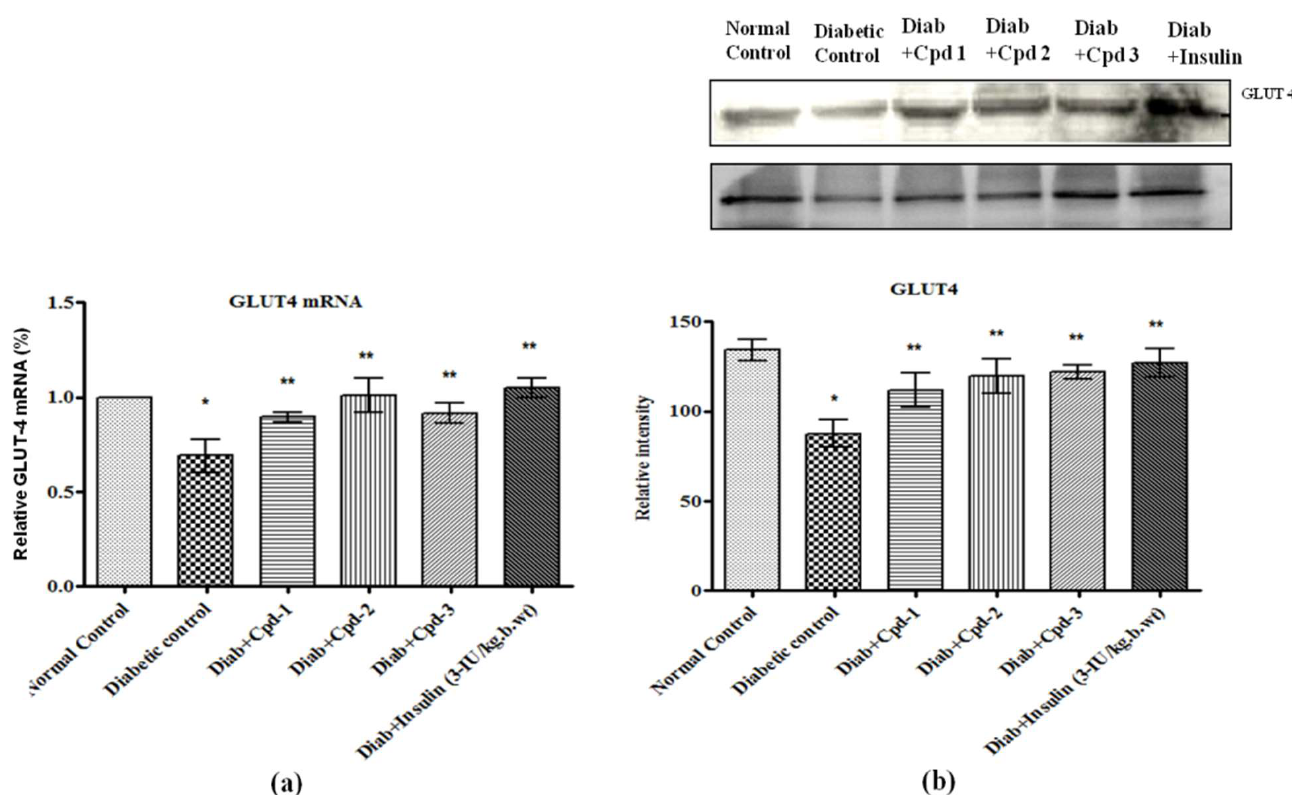
Figure 10. Effect of novel triterpenoids on ( a ) GLUT4 mRNA; ( b ) protein expression in skeletal muscle of STZ-induced diabetic rats compared with the effect of insulin. The expression of mRNA and proteins was assessed by real-time PCR and Western blotting. β-actin was used as a loading control. Each bar represents mean ± SEM of 3 observations representing 6 animals. Significance at p < 0.05; *, compared with control, **, compared with diabetic control.